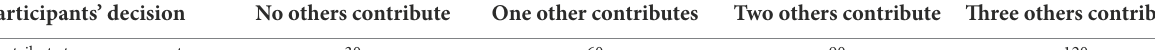
TABLE 1 Participants’ payoffs (tokens) matrix per